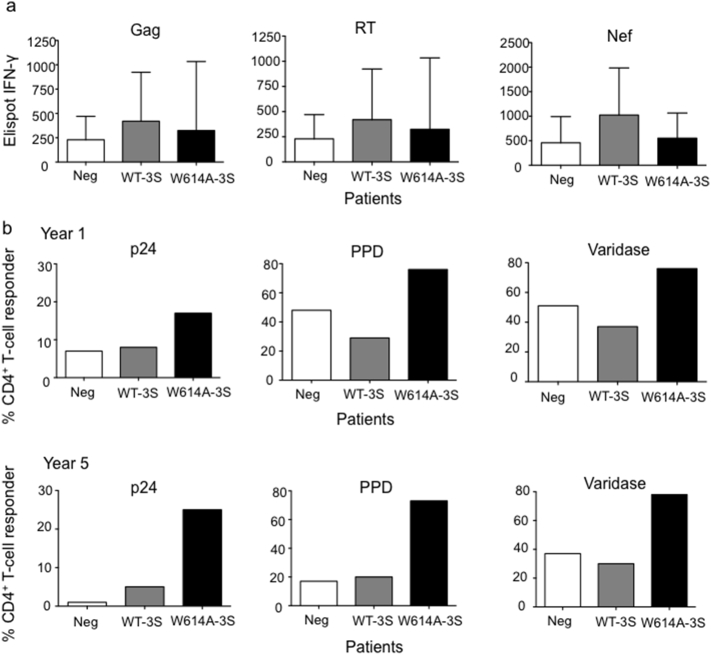
CD4+ and CD8+ T-cell responses in patients producing neutralizing W614A-3S Abs. (A) CD8+ T-cell responses to HIV 15-mer peptides covering Gag, RT, and Nef in ELISpot interferon-γ assays in counts in LTNP patients subdivided into three groups according to their capacity to produce W614A+-3S NAbs, non-neutralizing WT-3S+ Ab only, or neither subtype (Neg). Data are done at year 1 after cohort entry. Individual sums of positive responses to HIV peptide pools are shown. Results are expressed as spot-forming cells (SFCs)/106 PBMCs. The positive threshold was 50 SFCs/106 PBMCs. (B) CD4+ T-cell responses to HIV p24 protein and recall antigens (tuberculin (PPD) and varidase) in a proliferation assay after 3H–thymidine incorporation in the different patient groups at years 1 and 5 after cohort entry. A positive response was defined by data > 3000 cpm and a stimulation index > 3. Results are expressed as a percentage of CD4+ T-cell responders.